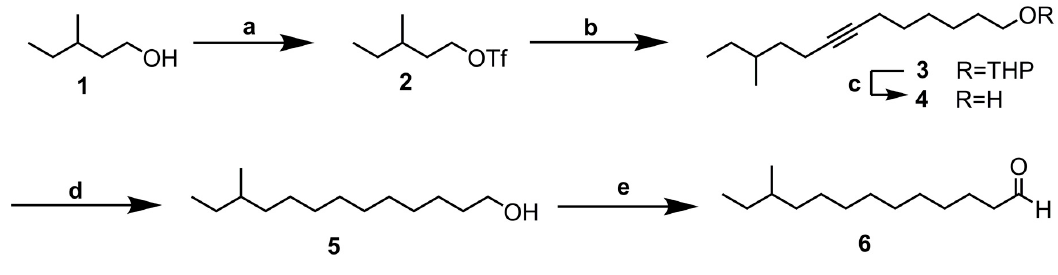
Figure 1. Synthesis of 11-methyltridecanal. (a) Tf 2 O, pyridine, CH 2 Cl 2 , -10 °C; (b)